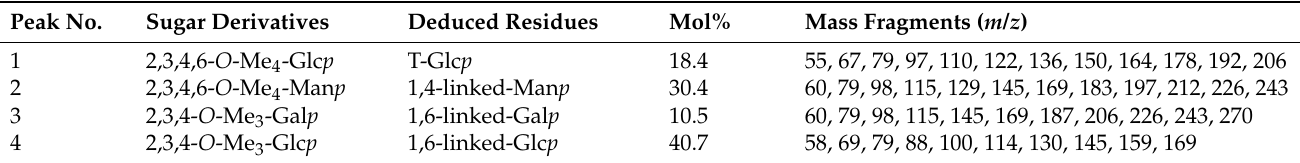
Table 1. Chemical shift assignments of SGP-1-1 by methylation